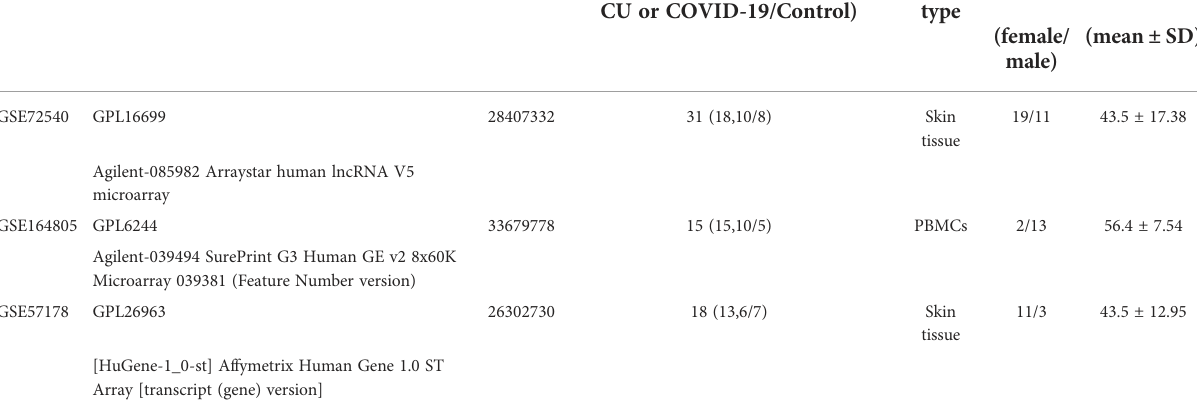
TABLE 1 Details of the RNA expression pro fi le datasets.